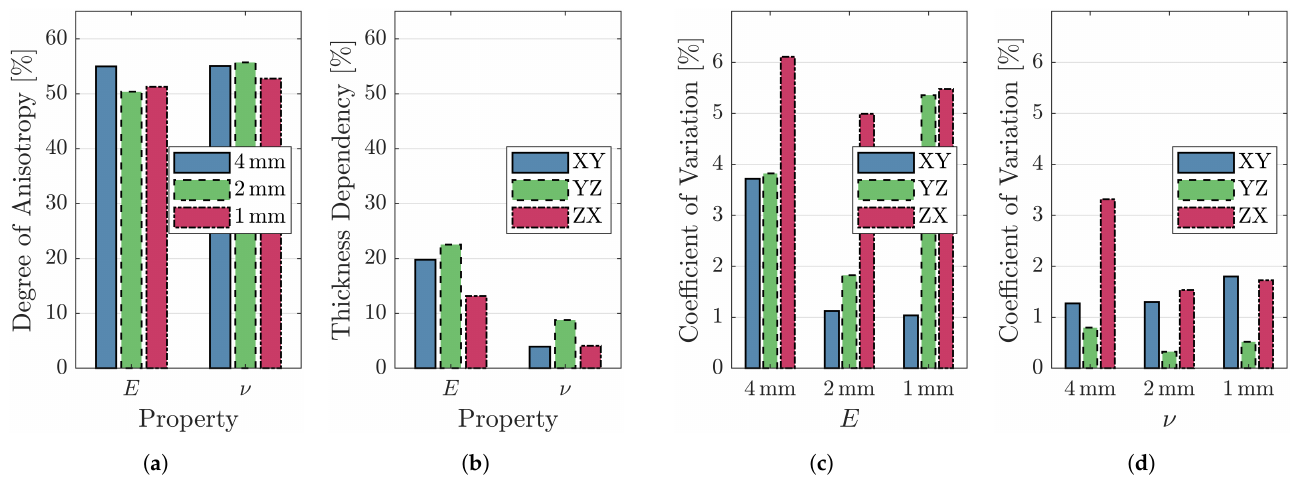
Figure 7. Maximum relative differences indicating ( a ) degree of anisotropy for each thickness and ( b ) thickness dependency for each orientation as well as scatter in ( c ) Young’s modulus E and ( d ) Poisson’s ratio ν .